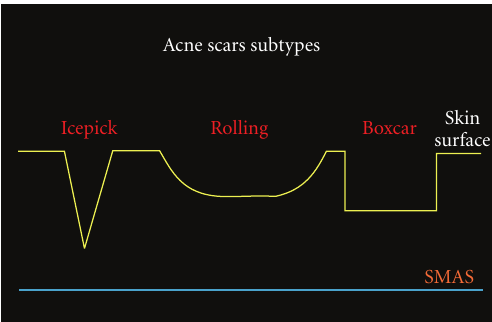
Figure 1: Acne scars subtypes.